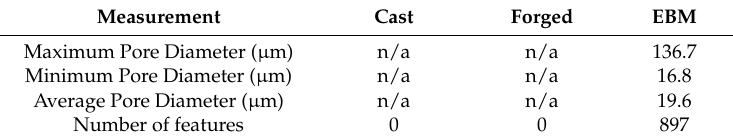
Table 3. Porosity measurements of Ti-6Al-4V variants (minimum voxel size of 6.7 µ